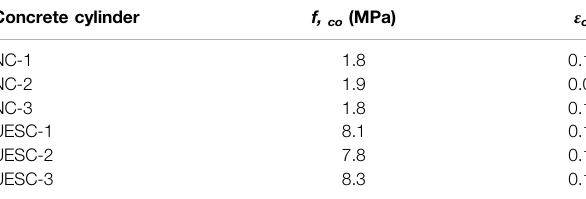
TABLE 2 | Test results of the control concrete